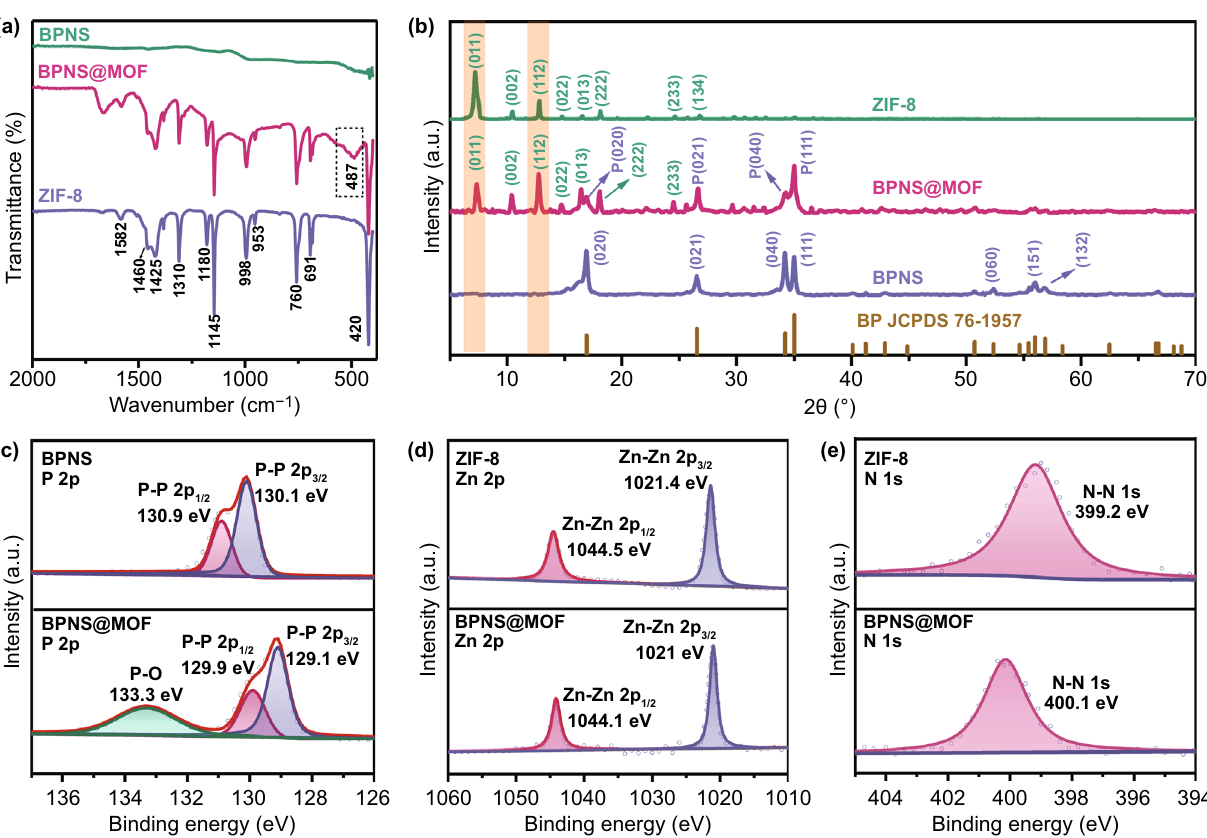
Fig. 2 a FTIR spectra of the BPNSs, BPNS@MOF and ZIF-8. b XRD patterns of the BPNSs, BPNS@MOF and ZIF-8. c High-resolution P 2p XPS spectra of the BPNSs and BPNS@MOF. d Zn 2p and e N 1 s XPS spectra of ZIF-8 and